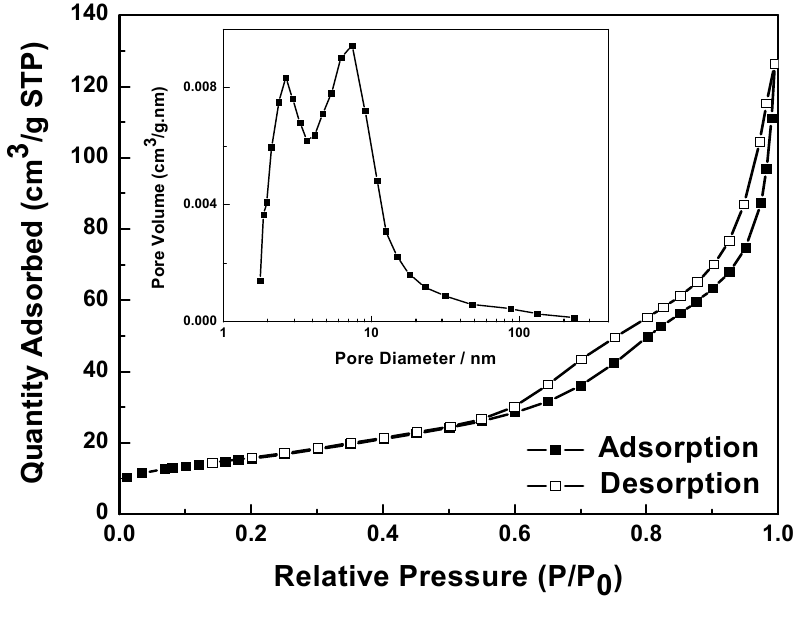
Figure 5. Nitrogen adsorption and desorption of flower-like NiO and BJH pore size distribution derived from the adsorption branch of the isotherm of flower-like NiO in the